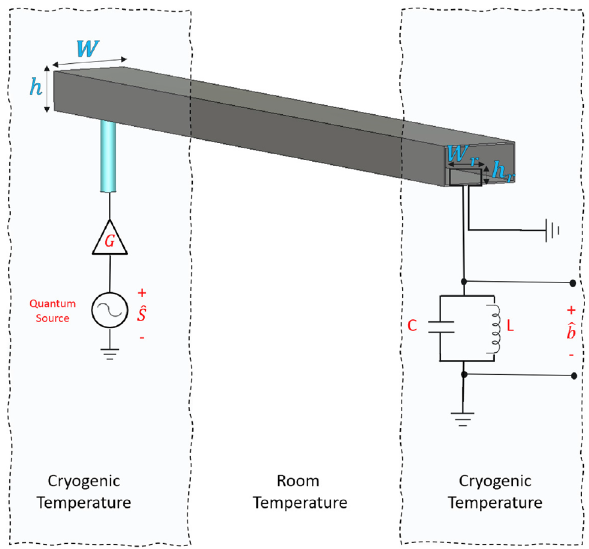
Figure 1. Proposed system for microwave transmission using a room-temperature